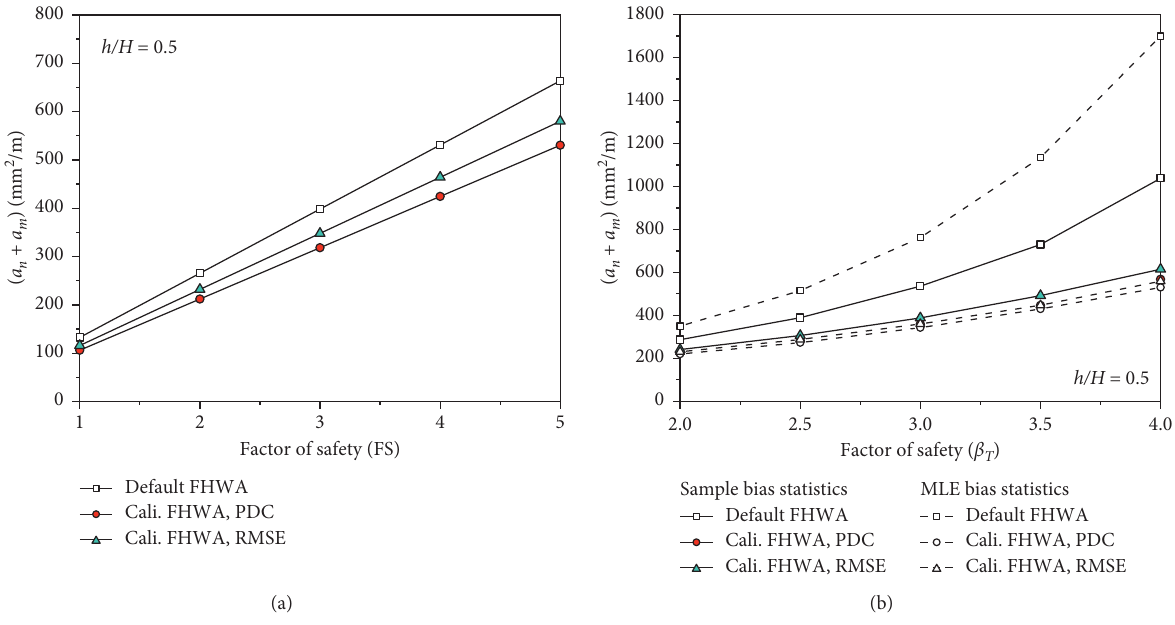
Figure 8: Plots of design outcomes of ( a